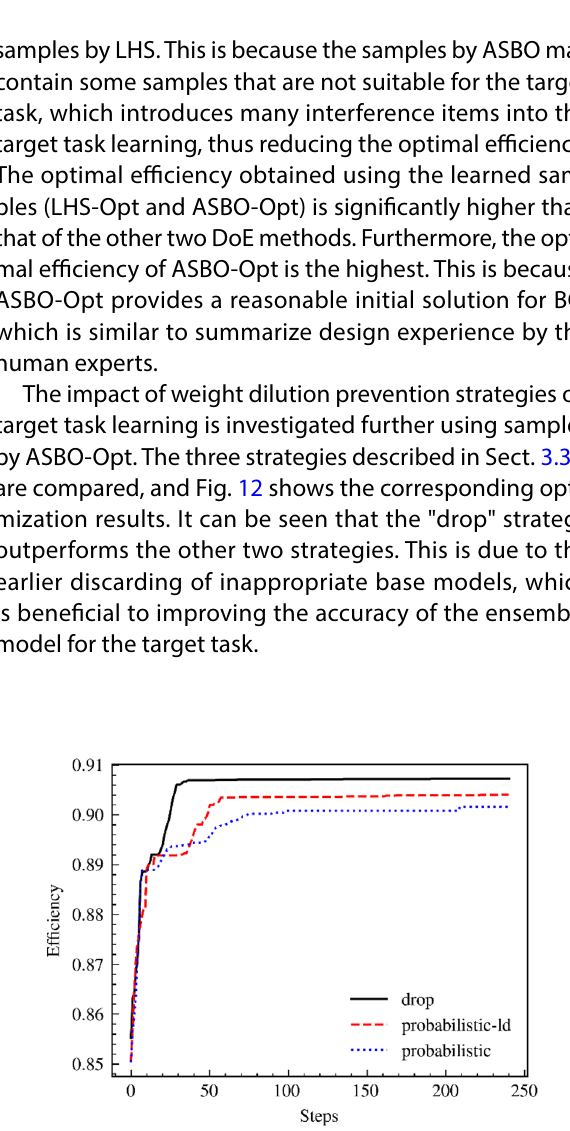
Fig. 11 Optimization results with four different source samples